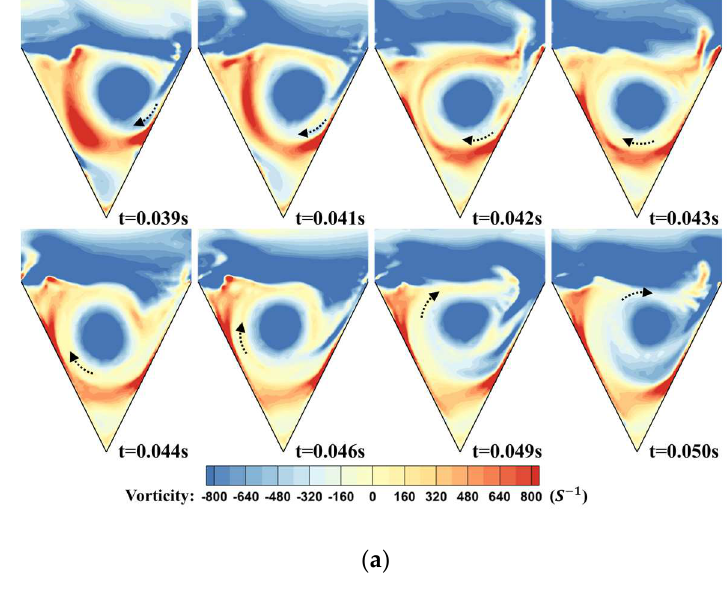
Figure 18. The vorticity contours of boundary vortices within grooves with ( a ) AR = 0.5, ( b ) AR = 8 at . M (cid:2)$ (cid:6) 5.44 × 10